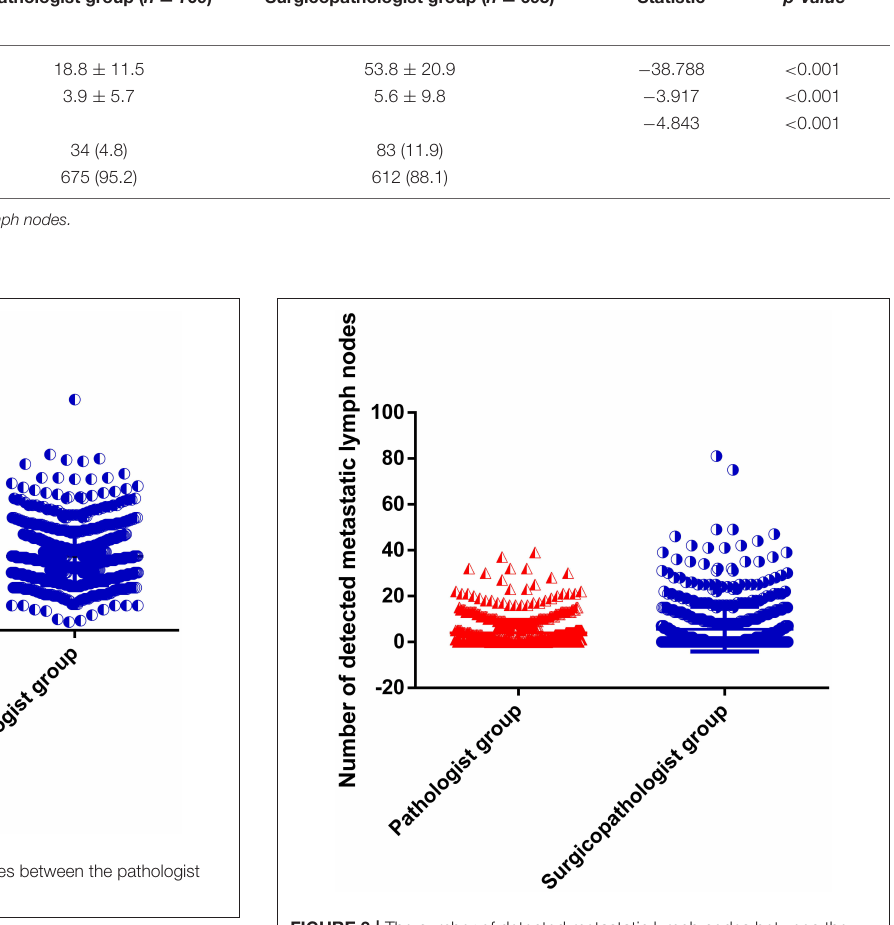
FIGURE 3 | The number of detected metastatic lymph nodes between the pathologist group and surgicopathologist